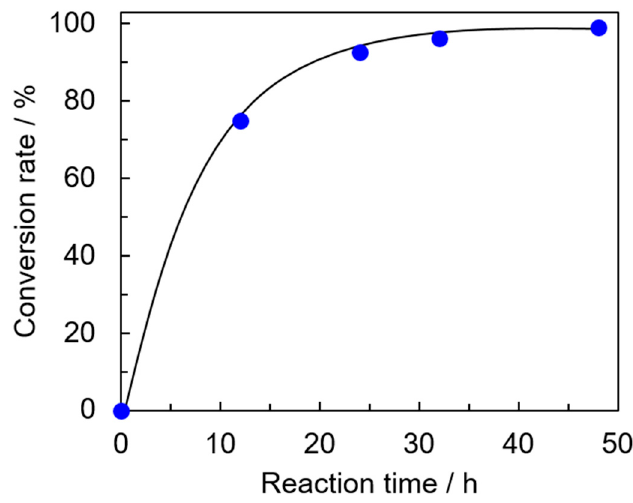
Figure 5. IL 1 conversion rate via a carbonylation reaction using gaseous CO 2 .